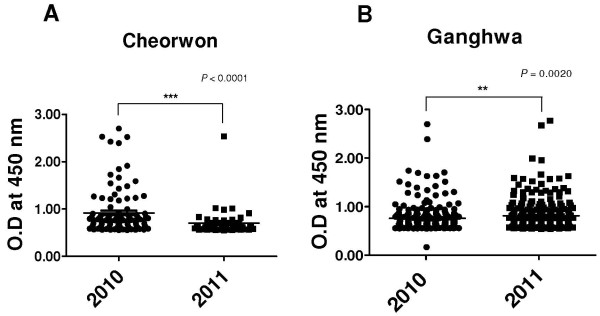
Comparison of immune responses to CSP between 2010 and 2011. Inhabitants of (A) Cheorwon and (B) Ganghwa.